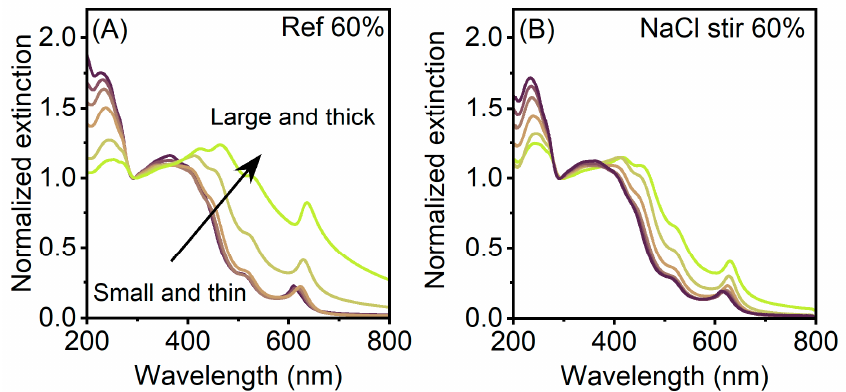
Figure A2. Optical extinction spectra of liquid ‐ phase exfoliated and size selected WS 2 nanosheet dispersions. The exfoliation was executed by tip sonication with an 60% amplitude. ( A ) Reference, ( B ) Pretreatment of the bulk starting material by stirring in H 2 O/NaCl. Size dependent spectral changes are indicated by the arrow in ( A ).